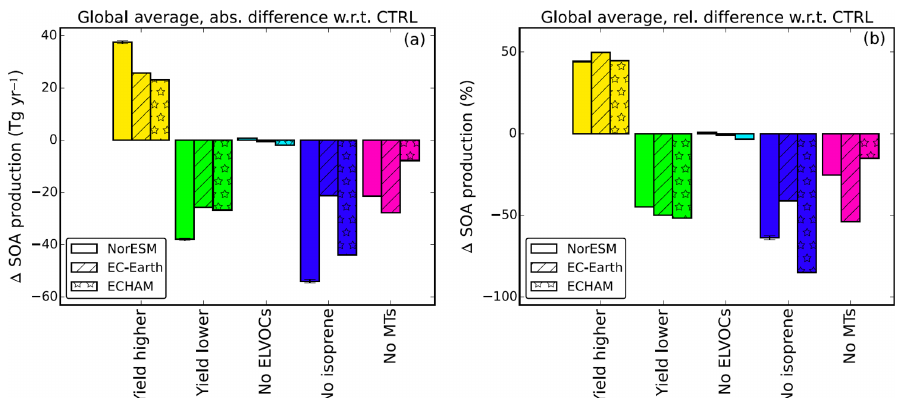
Figure 6. Bar plots of the average yearly SOA production changes in the three models. In (a) , the absolute difference between each sensi- tivity simulation and the CTRL simulations is shown and in (b) the relative differences between the sensitivity simulations and the control simulations are shown for all three models. Coloured bars indicate a significant difference in the simulation averages with a 95% confidence interval. The error bars denote the standard error of mean of the yearly differences.